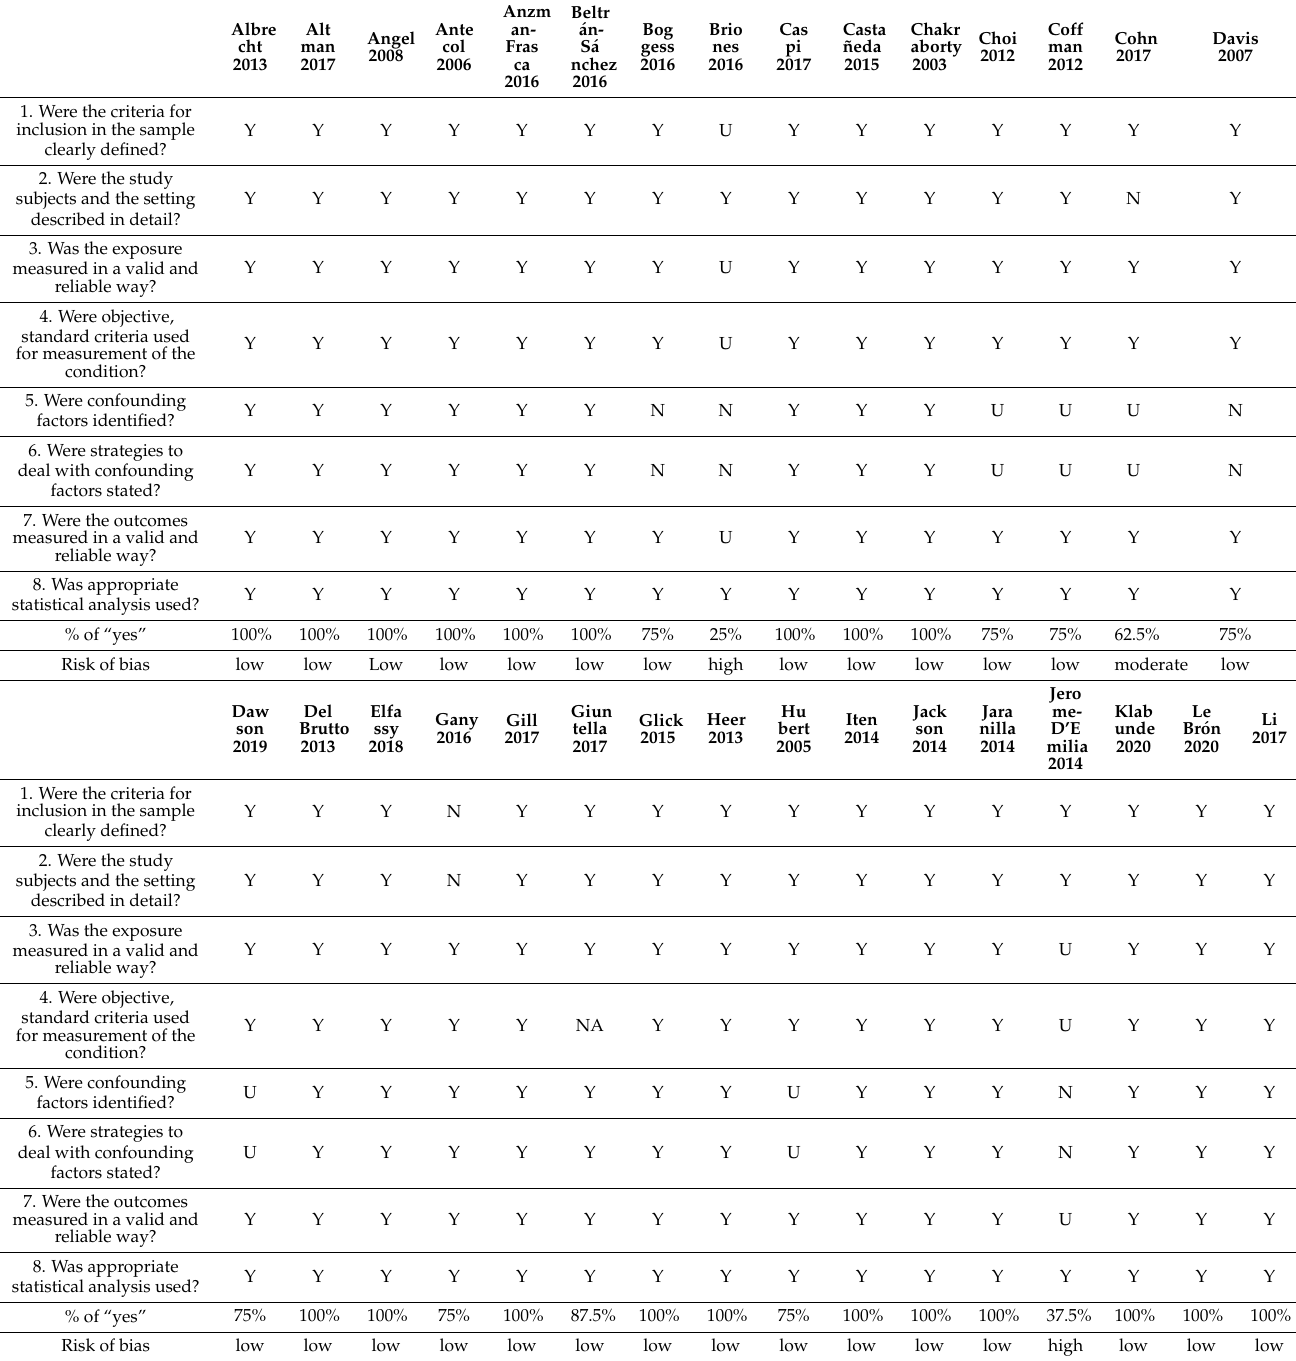
Table 3. JBI Critical Appraisal Checklist for Analytical Cross-Sectional